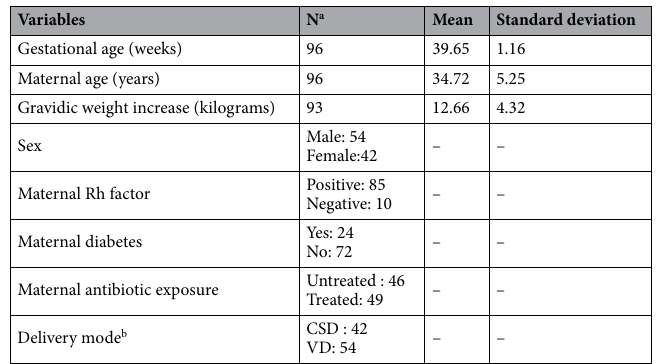
Table 1. Epidemiological variables of the population in study. a—refers to the number of couples mother- newborn for which data were available for each epidemiological variable; b—“CSD” stands for caesarean delivery, while “VD stands for vaginal